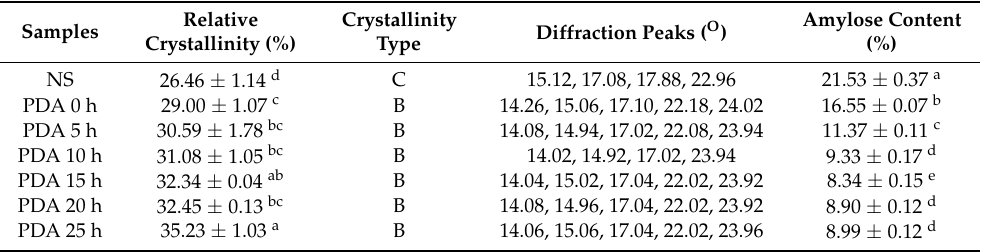
Figure 3. X-ray diffraction patterns of native and debranched combined with autoclave treatment starches. NS, PDA 0 h, PDA 5 h, PDA 10 h, PDA 15 h, PDA 20 h, and PDA 25 h indicate native starch and pullulanase debranching in different treatment times combined with autoclaving starch. Table 3. Crystallinity patterns and amylose content of native and debranched combined with autoclaved